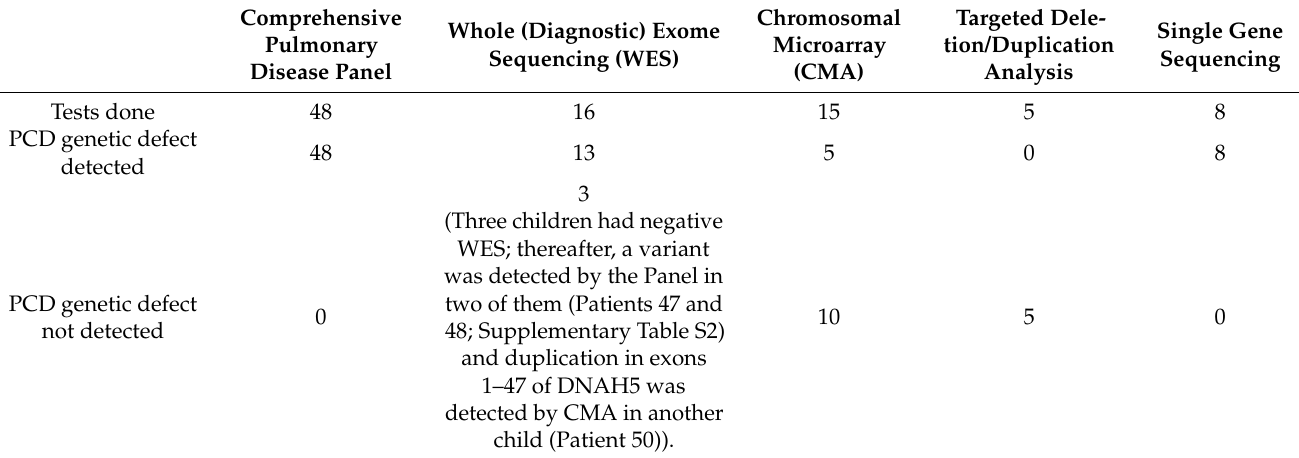
Table 1. Investigations performed in the studied children. Supplementary Table S2 describes the investigation of each child (1) .